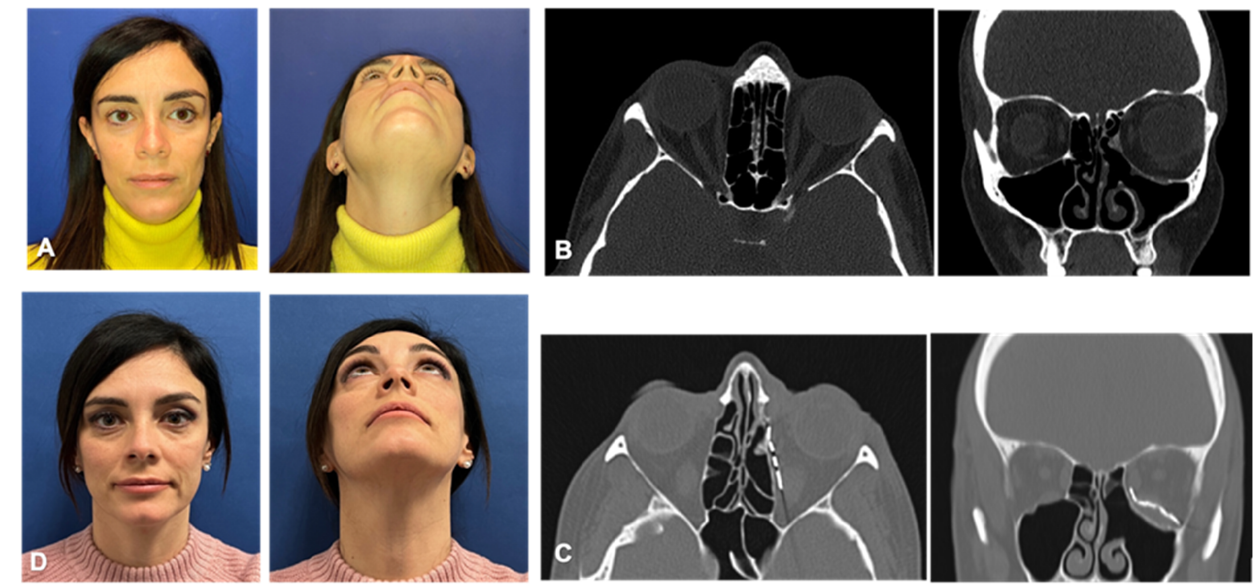
Figure 4. ( A ): Preoperative pictures showing left hypoglobus and enophthalmos. ( B ): Axial and coronal TC views demonstrating restored pneumatization of the paranasal sinuses, while showing resorption and remodeling of the medial wall and floor of the left orbit. ( C ): Axial and coronal post-operative CT views showing correct implant placement. ( D ): Clinical follow-up 12 months after surgery.